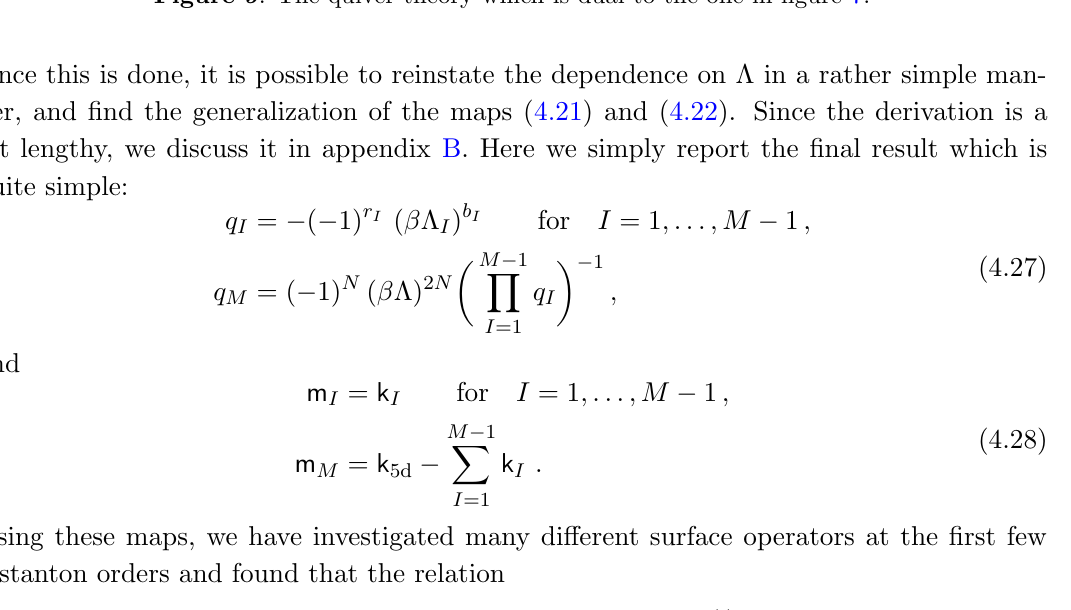
Figure 9 . The quiver theory which is dual to the one in (cid:12)gure